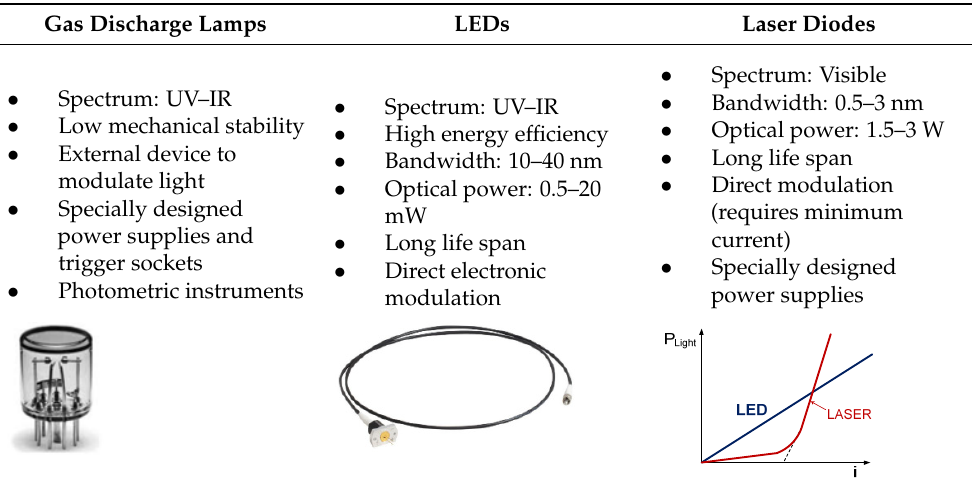
Table 1. The main characteristics of light sources used for optical sensing.